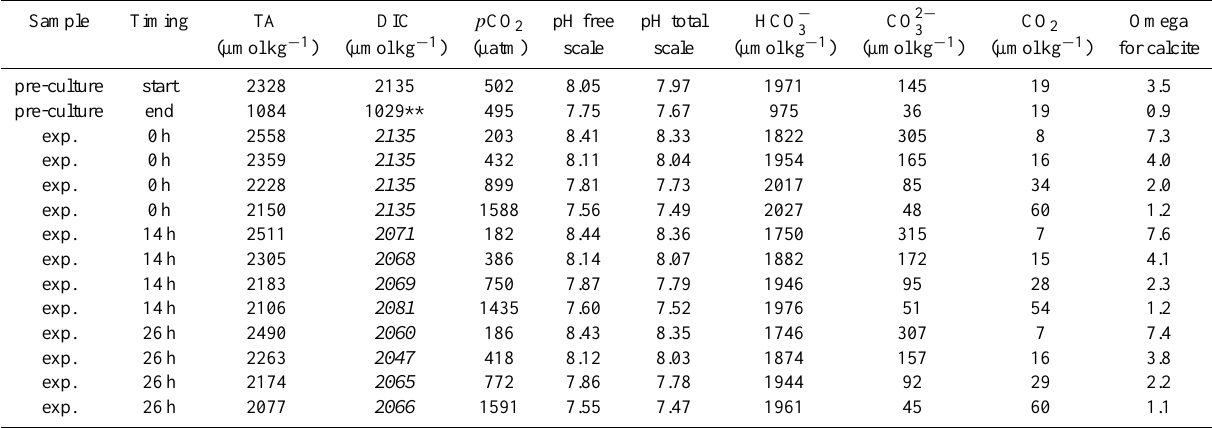
Table 1. Carbonate system data determined from total alkalinity (TA) and dissolved inorganic carbon (DIC) at 15 ◦ C, 34 salinity and 3.4µmoll − 1 phosphate using CO2sys (Lewis and Wallace, 1998) with the equilibrium constants given in Roy et al. (1993) at different times of the experiment. While all TA values were measured, meaningful values of DIC could only be obtained for the initial water (start) due to storage problems of the remaining samples (calculated DIC in